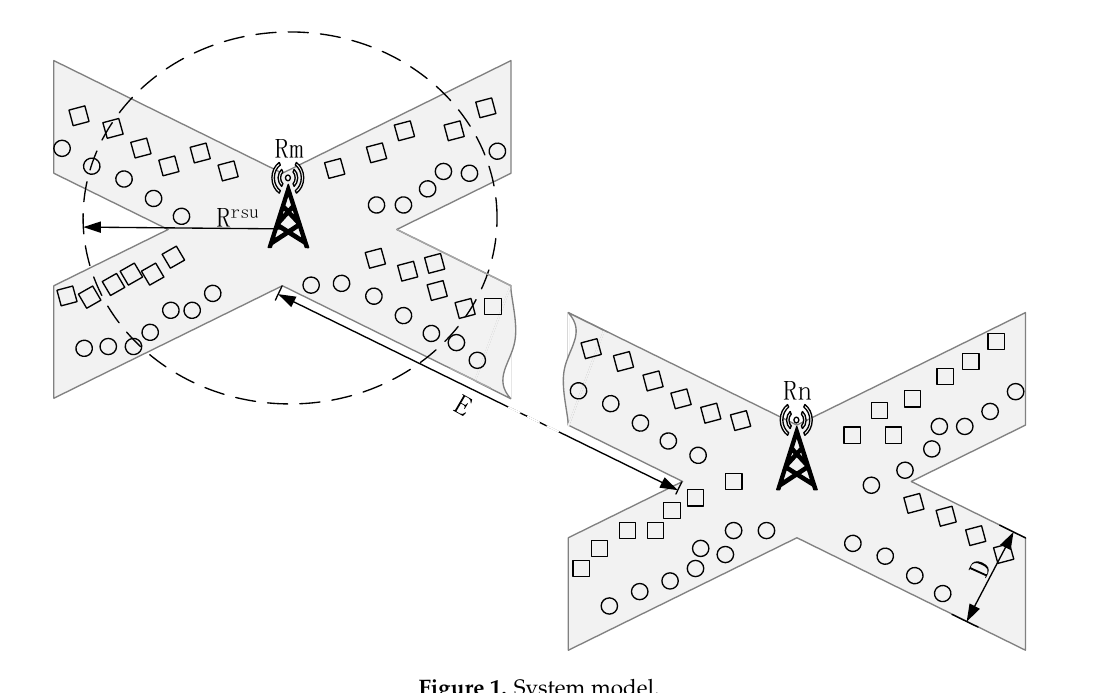
Figure 1. System Figure 1. System model.